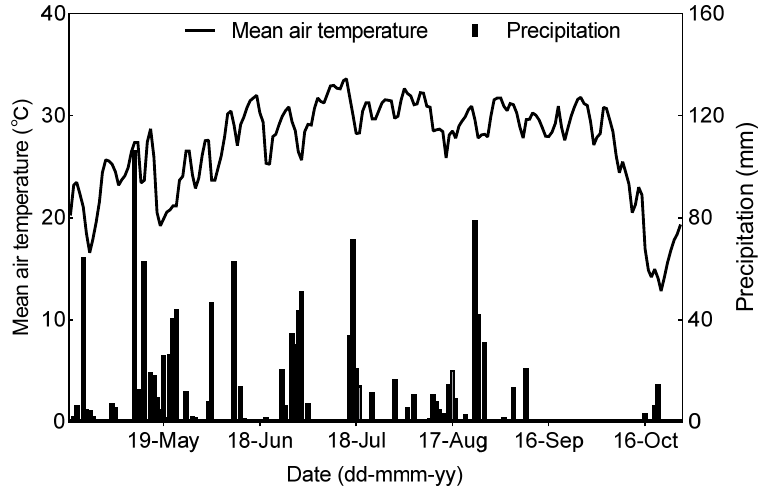
Figure 1. The average daily air temperature and precipitation in early and late rice seasons in 2021 at the experimental site.